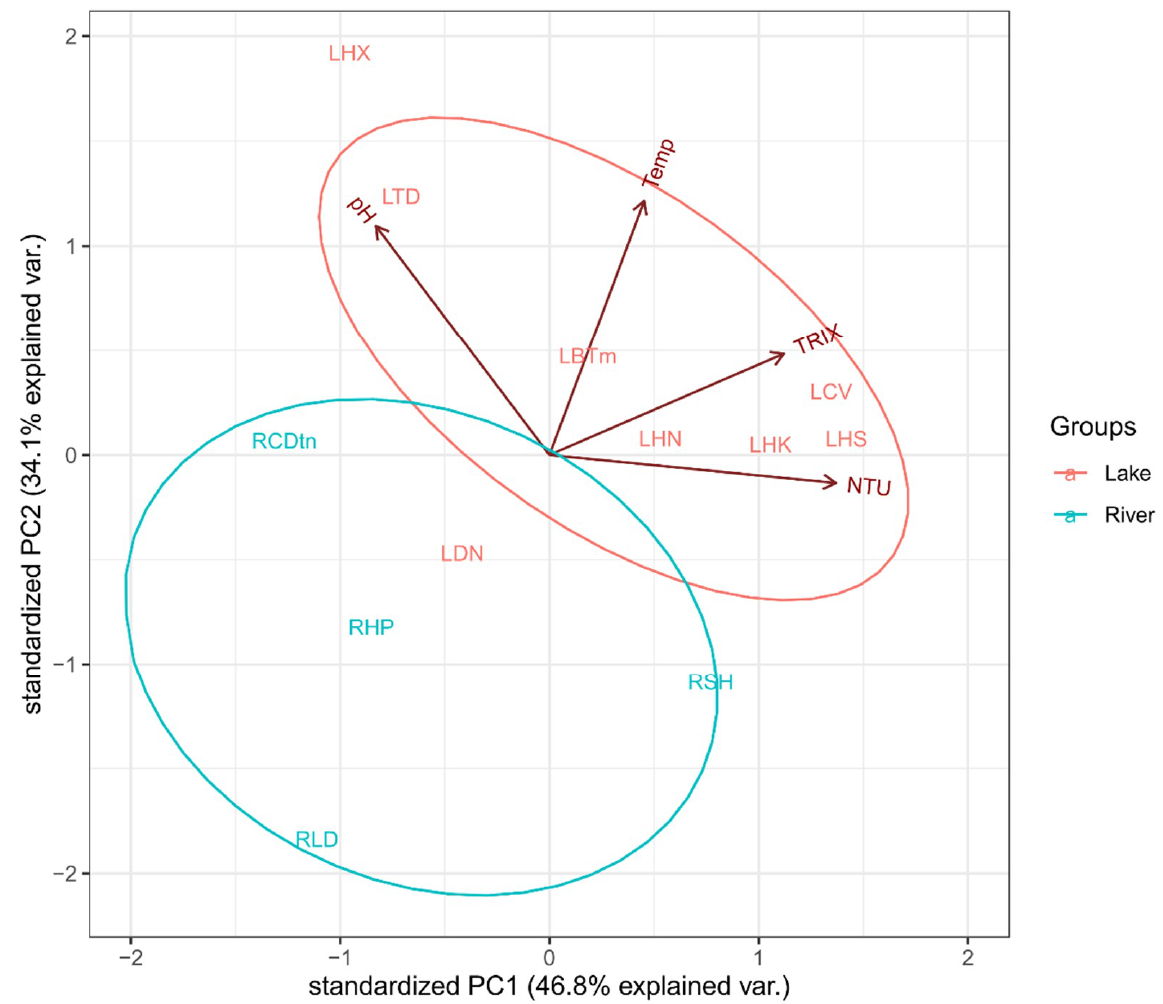
Figure 3. Principal component analysis of water characteristics at 12 sampling sites (see Table 1 for the short codes of the sampling sites).